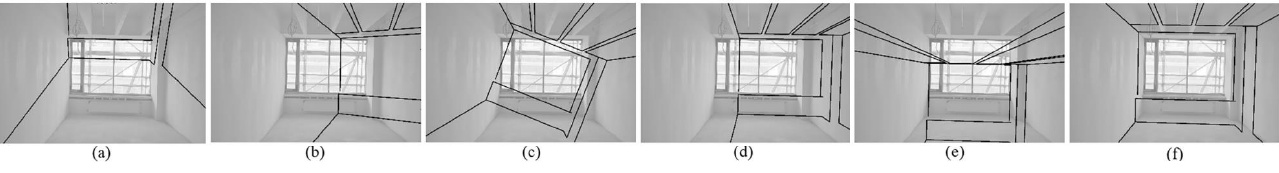
Figure 5. Projections of input model lines with divergent camera poses by rotation ( a – c ) and translation ( d – f ) [4].